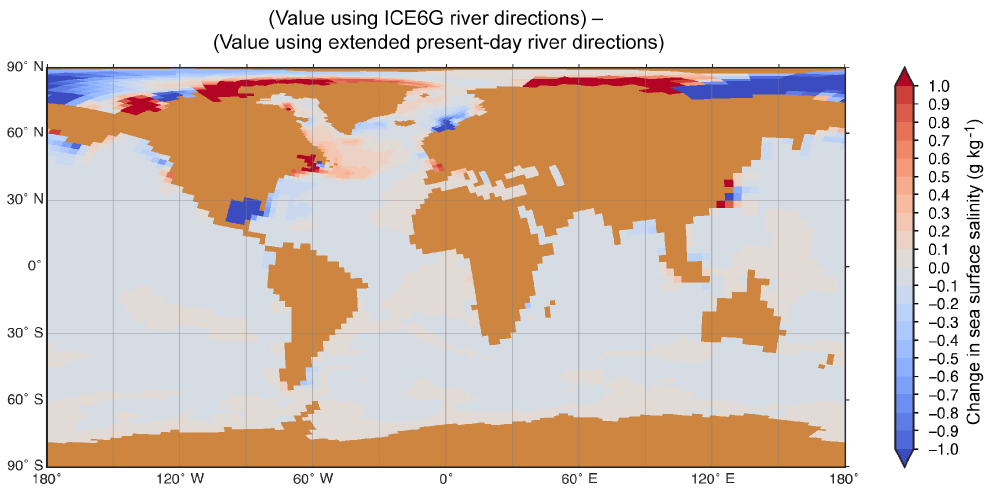
Figure 10. Changes in the surface ocean salinity between simulations run in the MPI-ESM model of the LGM using extended present-day river directions and using dynamic river directions. The changes are defined such that an increase in the version using dynamic river directions is